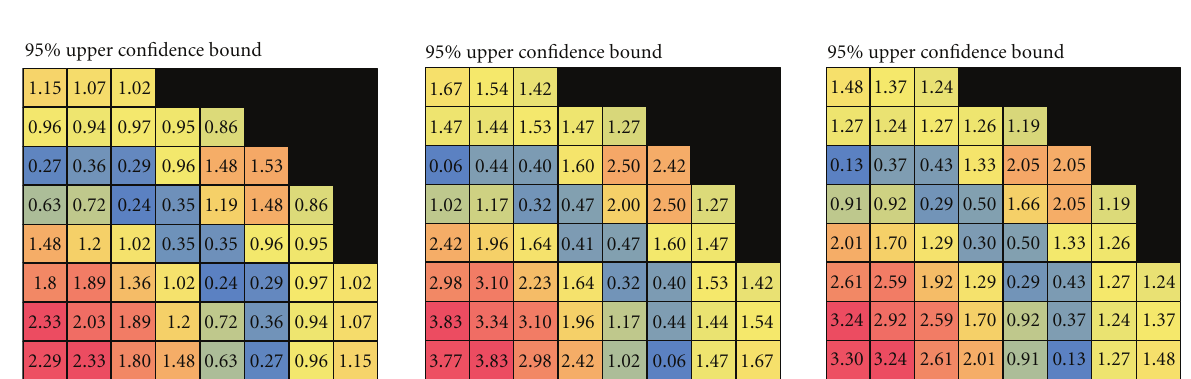
Figure 7: The 95% confidence bounds are shown for the relative standard deviations corresponding to Figure